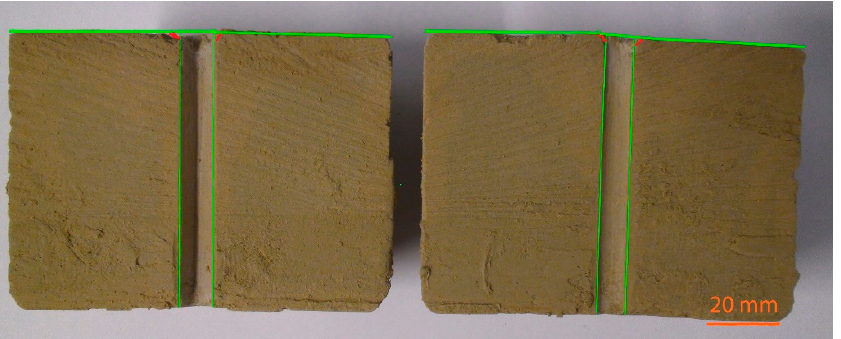
Figure 9. Specimen cross section B–B´ after the test (see Figure 8c)—grout mixture B5 based on Bentonit 75 (the edge of the failure area in red, the initial hole and inlet side in green).